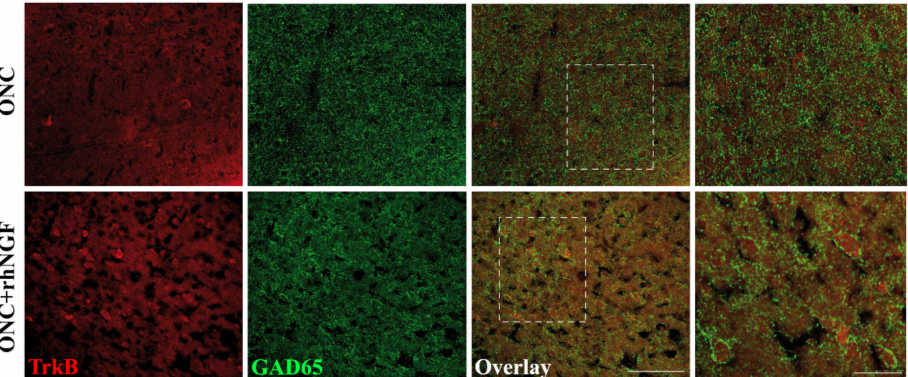
of rats. Representative TrkB (red) and GAD65 (green) immunofluorescent staining in the contralateral visual cortex of coronal brain sections from ONC+rhNGF or ONC rats. A weak TrkB expression is evident in a minor number of cell bodies and in neuronal varicosities, while a widespread GAD65 staining is present in the ONC VCx. Upon rhNGF treatment, TrkB positive cell soma and neuronal endings are strongly enhanced. Please, note the GAD65 immunoreactive afferents surrounding most of the TrkB positive cell soma in the ONC+rhNGF VCx (inlet, dotted lines). (Scale bars: 200 mm; inlet: 50